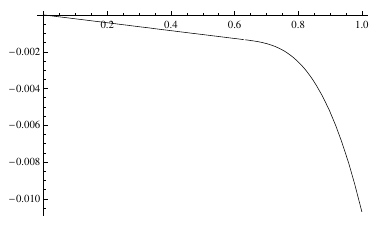
Figure 9. Graph of the solution for the problem (4.1),